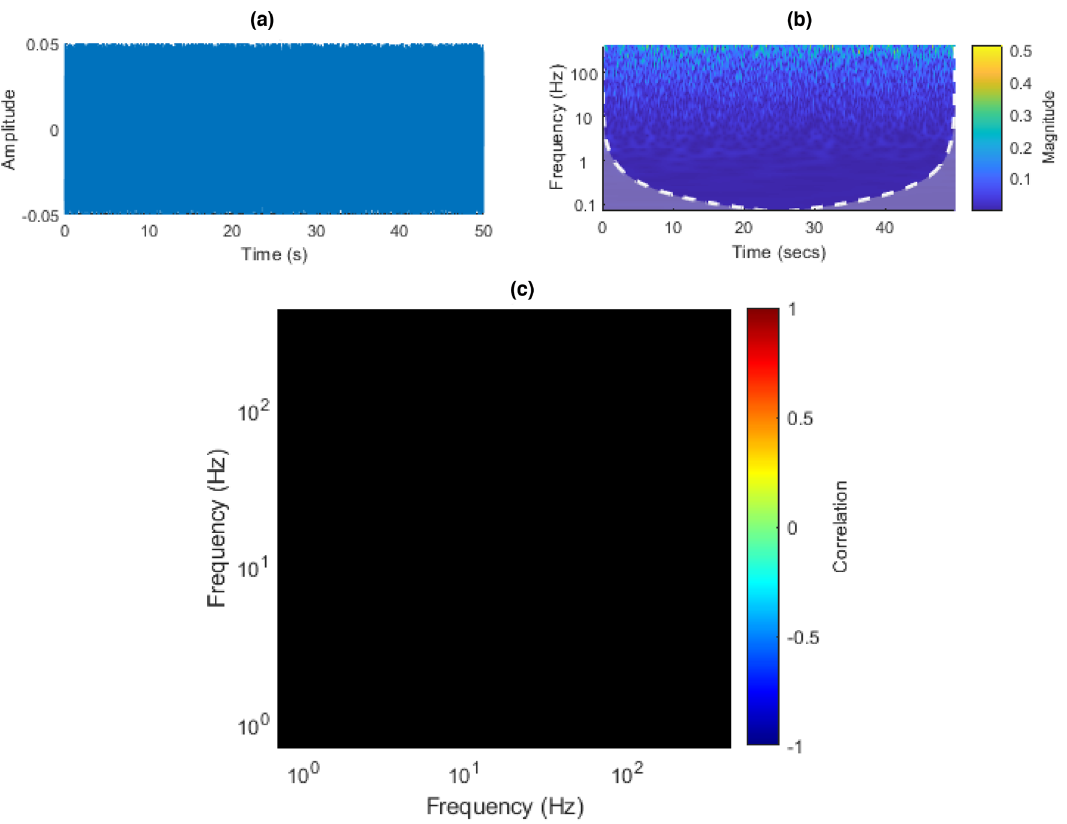
Figure 17. ( a ) White noise time domain plot. ( b ) White noise CWT. ( c ) White noise ISPCM, black elements represent non-statistically significant correlations at an FDR α of